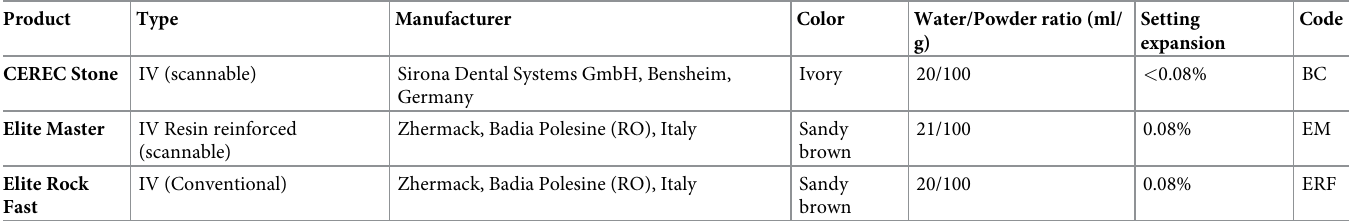
Table 1. Details and material characteristics of tested gypsum